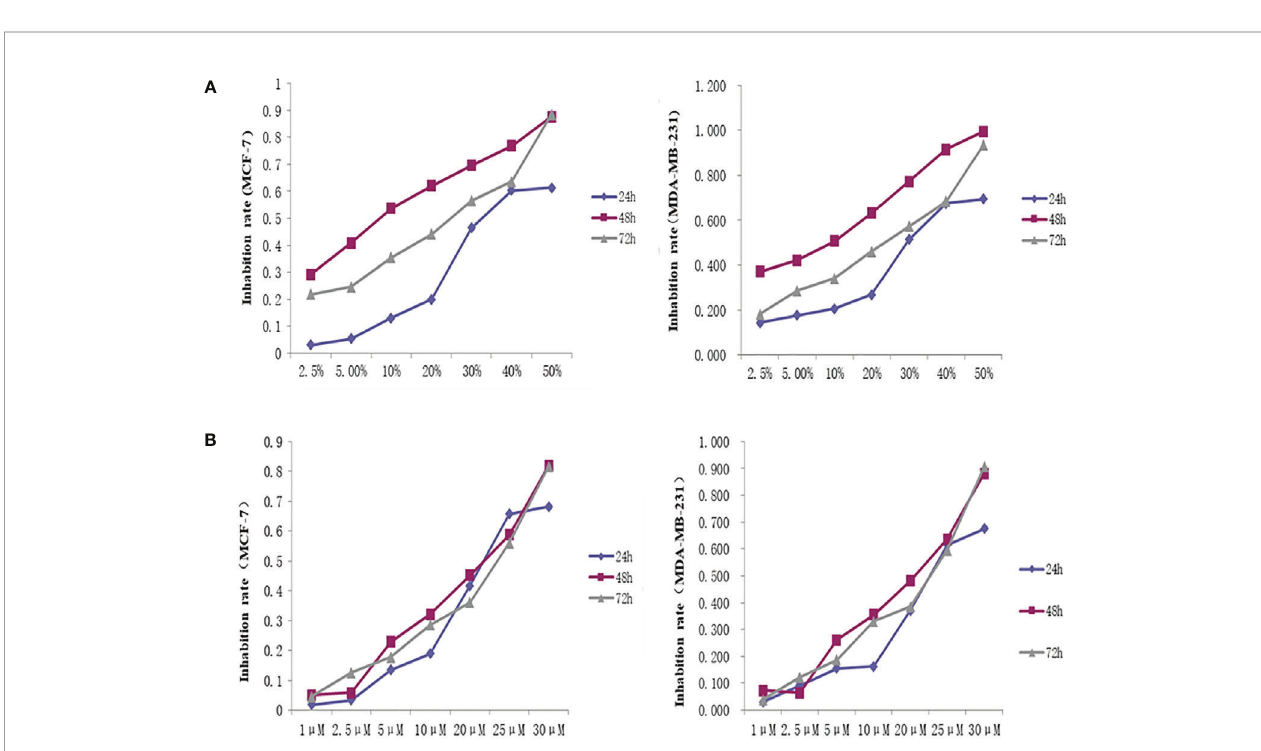
FIGURE 9 | Inhibition curve of different concentrations of THSWD serum and inhibitor Lonafarnib on MCF-7, MDA-MB-231 cells. (A) THSWD serum (B) inhibitor